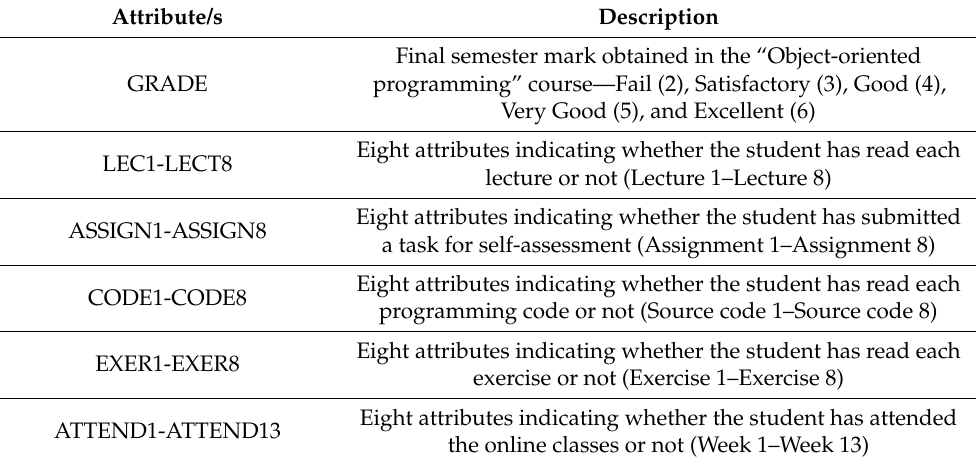
Table 1. Attribute